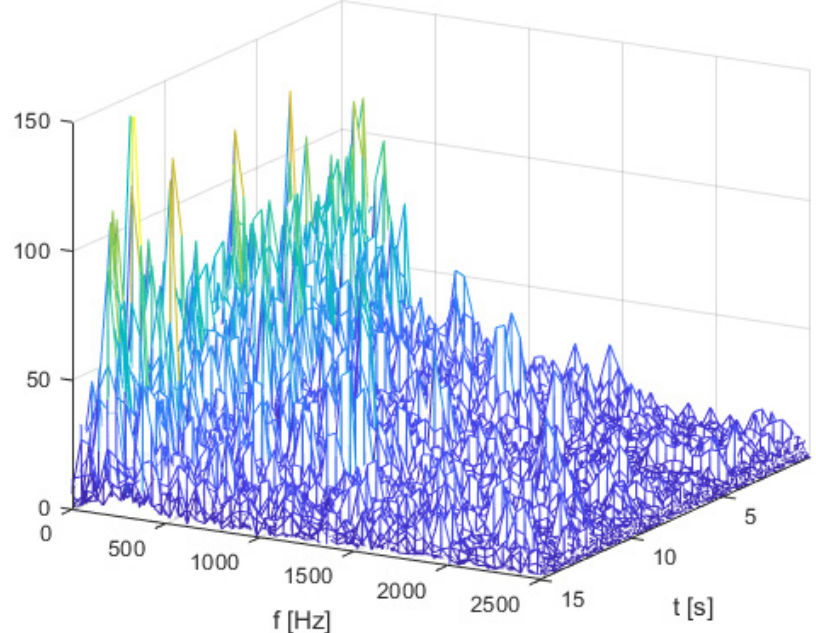
Figure 6. Spectrogram STFT for shale.